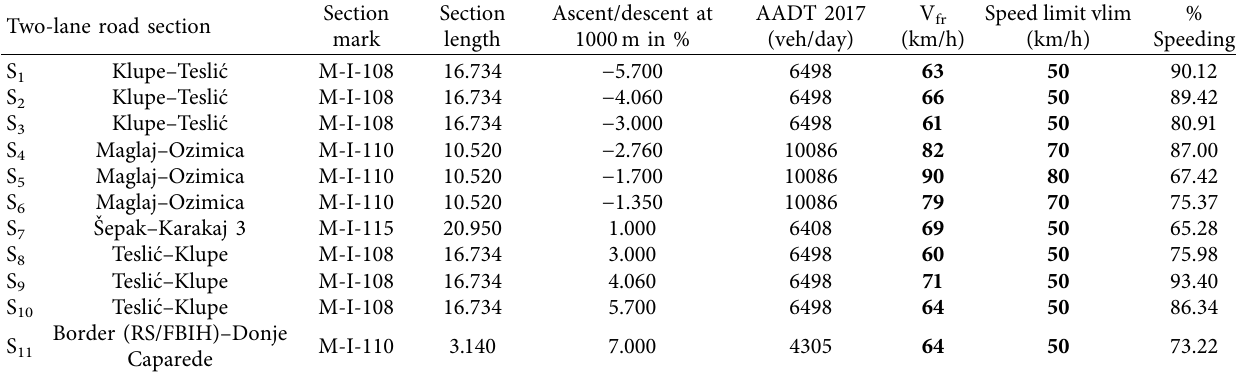
Table 2: Percentage of speeding as a function of difference between free and speed